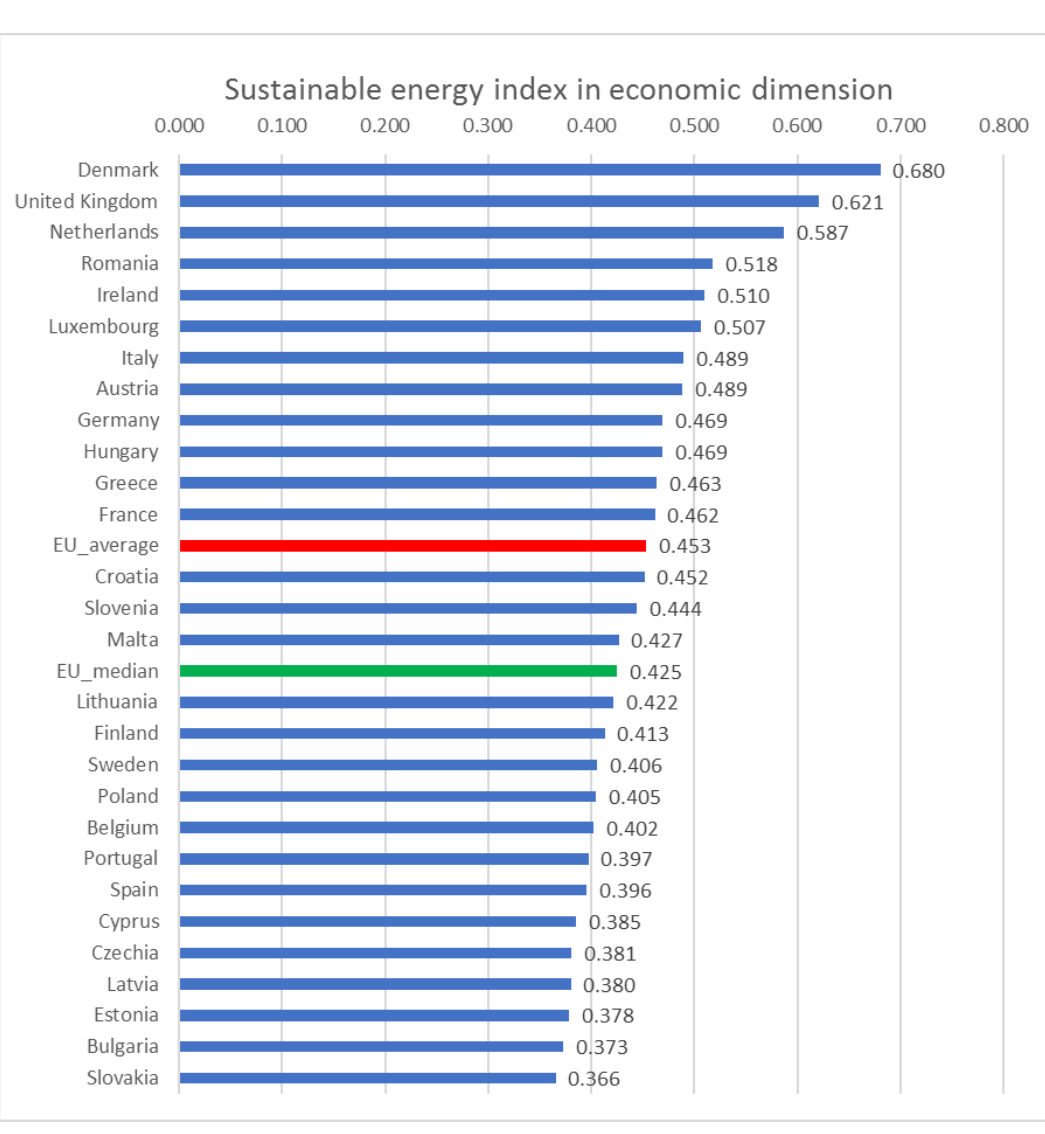
Figure 2. Economic dimension index of sustainable energy in 2017 for the EU-28 Member States. Table 4. Results in economic dimension partial indexes.